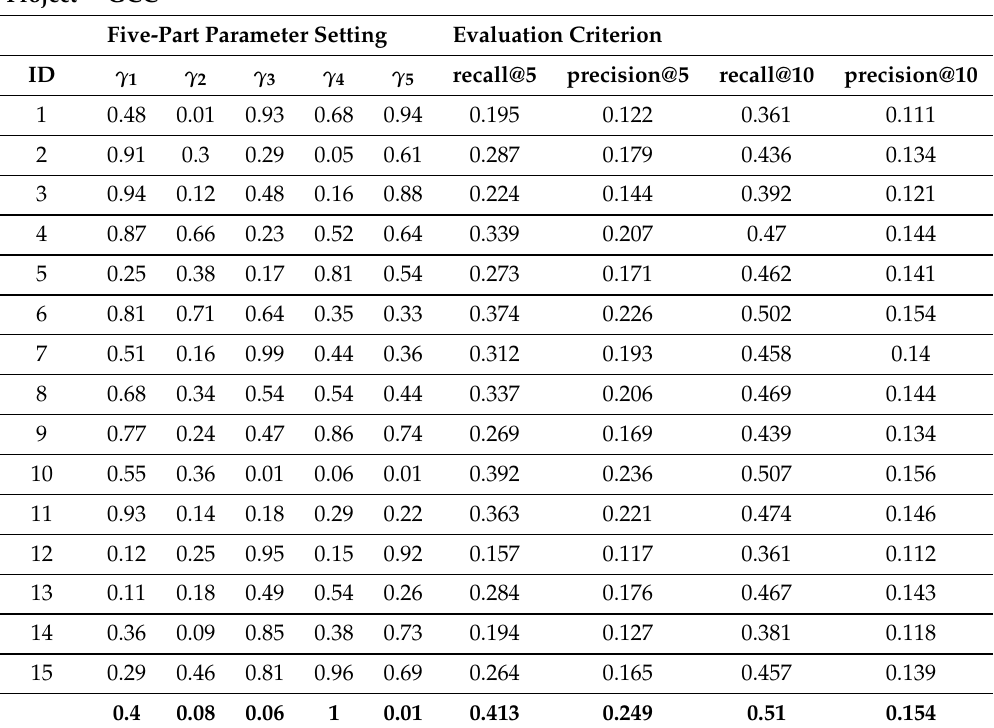
Table 6. Effects of different parameter settings on experimental results for the GCC dataset, and the last behavior in the table is the parameters measured by our proposed ABC-DR algorithm for the GCC